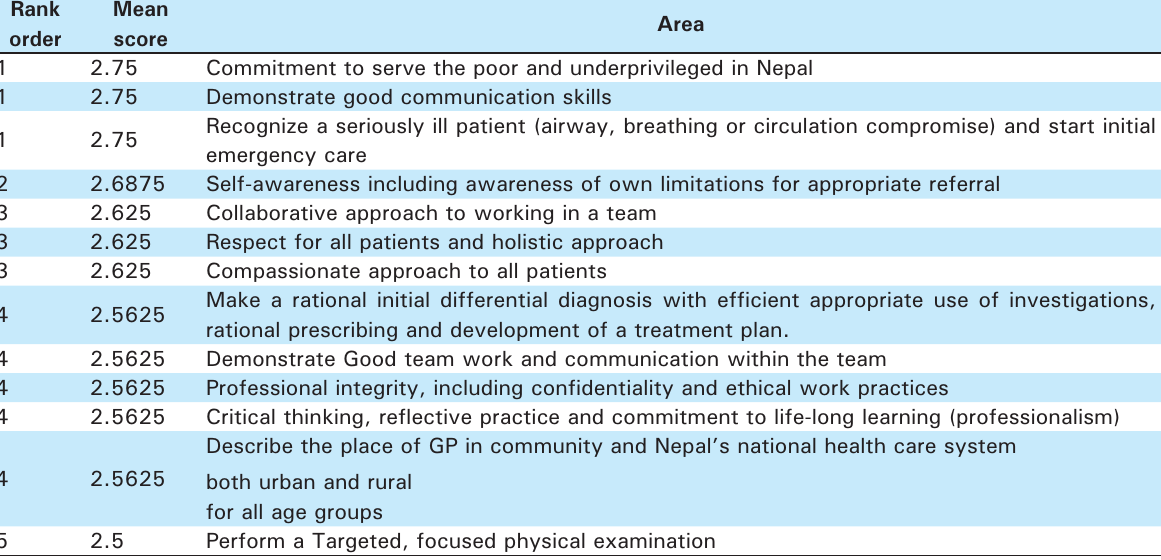
The fi nal table (table 4) gives a prioritized list of the key areas identifi ed from Knowledge, Skills and Attitudes that achieved a mean score of 2.5 or greater out of a maximum of